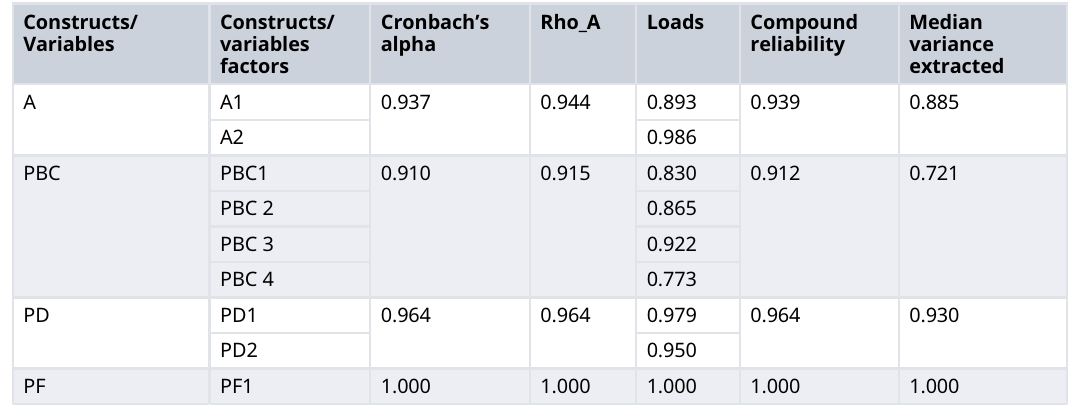
Table 1. Assessment results of the measurement